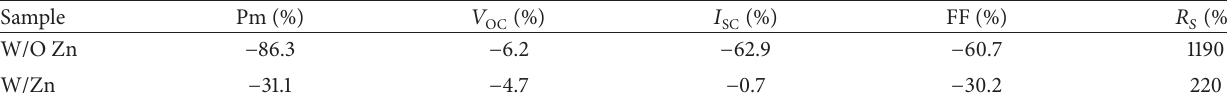
Table 1: Changes in normalized electrical parameters of PV cells with and without Zn after 3000 h.